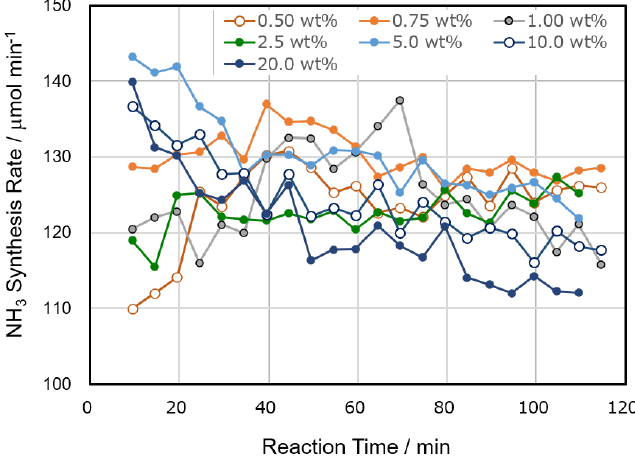
Figure 4. Time courses for the catalytic activities of Al 2 O 3 -loaded Ni catalysts (KC, 773) for the plasma synthesis of ammonia. The amounts of loaded Ni are shown in the figure. Reaction conditions were the same as those in Figure 1.